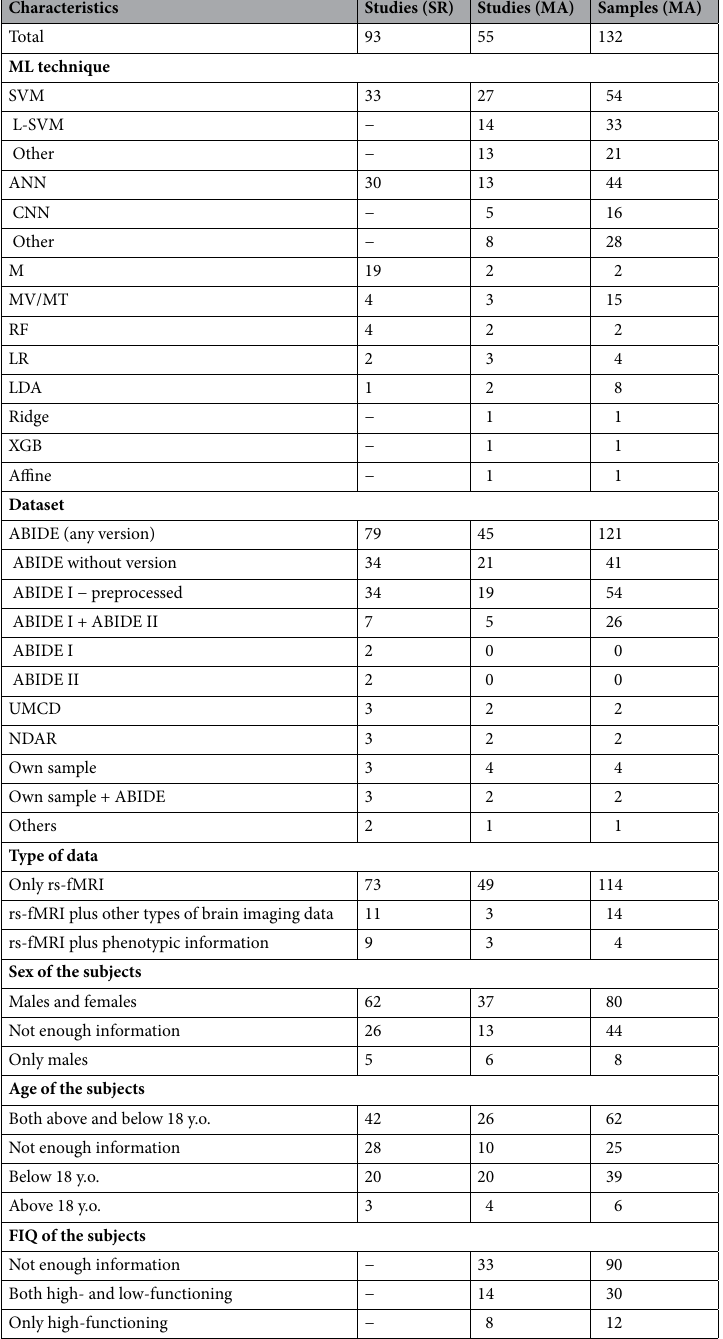
Table 1. General characteristics of the studies selected in the systematic review (SR) and the studies and samples included in the meta-analysis (MA). Note that for the dataset, sex, and age of the subjects, the sum of the column Studies (MA) is greater than 55 due to articles with multiple samples included in different categories. L-SVM Linear SVM, CNN Convolutional Neural Network, Ridge Ridge classifier, XGB Extreme Gradient Boosting, Affine Affine-Invariant, y.o. years old, FIQ Full Intelligence Quotient. Significance values are given in